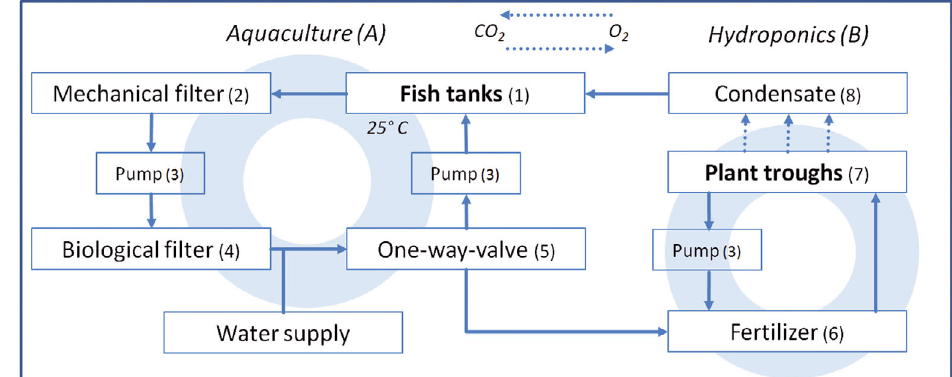
Fig. 1. The a quaponic s ystem for (nearly) emission free t omato a nd f ish pro duction in greenhouses (ASTAF-PRO) consists of 2 independent recirculation systems connected unidirectionally from the fish component to the plant component. (A) The aqua- culture unit is in principle a recirculating aquaculture system (RAS), and (B) the plant unit resembles a hydroponic system. The RAS consists of (1) fish-rearing tanks, (2) a lamellae clarifier, (3) a recirculation pump system, and (4) a biofilter (trickling filter) for nitrification. (5) A 1-way valve connects the RAS to the (6) fertilizer reservoir of the separate hydroponic unit, where the fish water can be optimized for specific demands of the plant species and a recirculation pump system provides the flow from the reservoir within the hydroponic unit to feed (7) the plant troughs. The plants take up water and nutrients and vaporize water that is mainly gained via condensation by (8) air-conditioning and then re-fed into the aquaculture unit. In addition to value-added chains for water and nutrients, carbon dioxide is used as a nutrient for plants, which in turn provide oxygen via